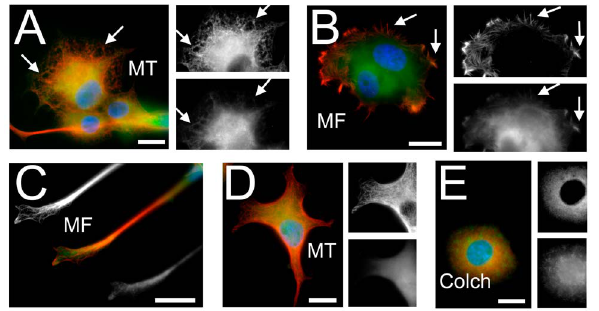
Figure 2. Association of Praja1 with the cytoskeleton of neuronal differentiated PC12 cells. (A) Epifluorescence microscopy reveals a filamentous intracellular distribution of EGFP::Praja1 (green), largely overlapping with microtubules (MT, red). Arrows indicate double-labelled filamentous structures in the soma. (B) Co-labelling of EGFP::Praja1 with microfilaments (MF) with phalloidin-rhodamine also indicates a partial association, in particular at filopodia (arrows) and membrane ruffles. (C) EGFP::Praja1 is also observed in outgrowing neurites and growth cones. (D) EGFP does not show a comparable filamentous distribution, and does not localize to outgrowing neurites. (E) Disruption of microtubules with colchicine (Colch) results in a diffuse intracellular localization of EGFP::Praja1. Pictures show cells transfected with the transcript variant praja1.1 ; comparable results were obtained after expression of transcript variant praja1.2 . Sectors in black and white depict EGFP::Praja1 (lower) and the corresponding cytoskeletal element (upper). Bars: 10 m m in A, B, D and E; 5 m m in C.